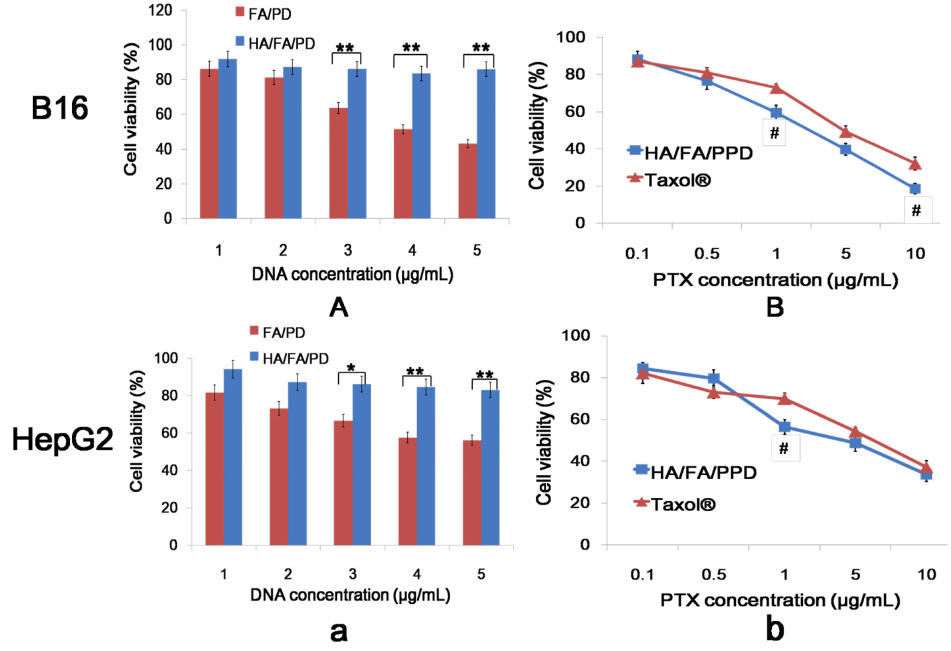
Figure 6. Cytotoxicity of various concentrations of HA/FA/PD, FA/PD, HA/FA/PPD and Taxol ® on B16 ( A , B ) and HepG2 ( a , b ) cells ( n = 3). * p < 0.05, ** p < 0.01, statistically significant difference between FA/PPD and HA/FA/PPD; # p < 0.05, statistically significant difference between Taxol ® and